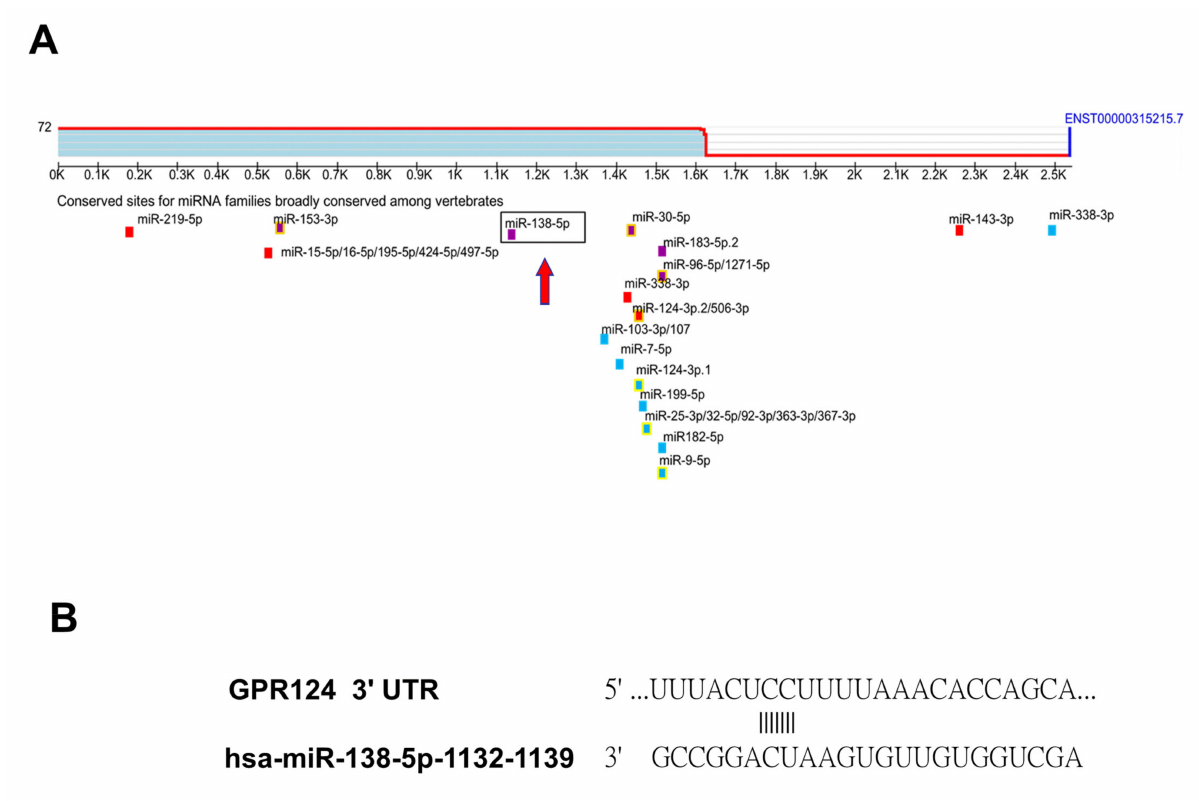
Figure 3. To identify that GPR124 is a direct target of miR-138-5p by Microarray and Target Scan. ( A ) After the identification of miRNA expression signatures by miRNA microarray analysis in endometrial tissue, we searched for putative targets using established miRNA target prediction programs, target Scan 7.2, a web server, in order to explore target genes of miR-138-5p. GPR124 was predicted as a potential target of miR-138-5p by target Scan. We focused on GPR124 because of its established relevance in angiogenesis and atherosclerosis possibly related to embryo implantation. ( B ) Target Scan analysis forecasted one putative miR-138-5p binding site within the 3 (cid:48) UTR of